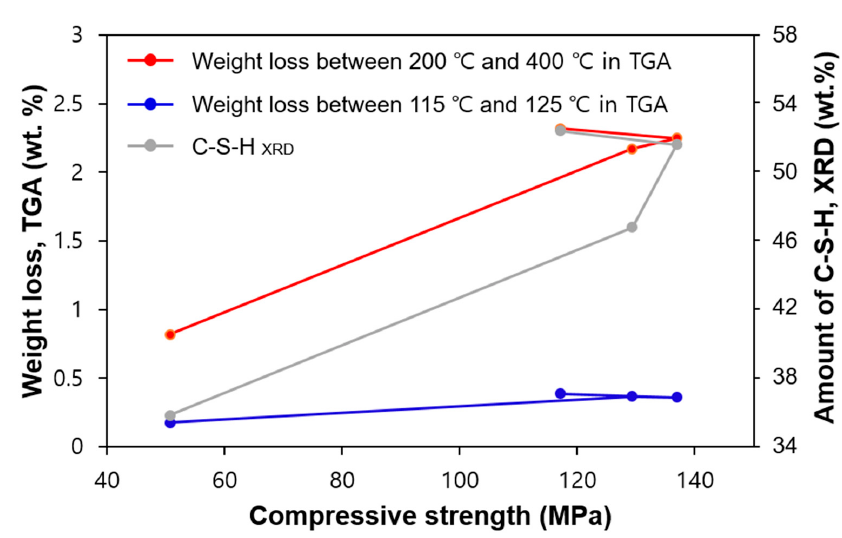
Figure 11. Relationship between strength development and the estimated amount of C-S-H .